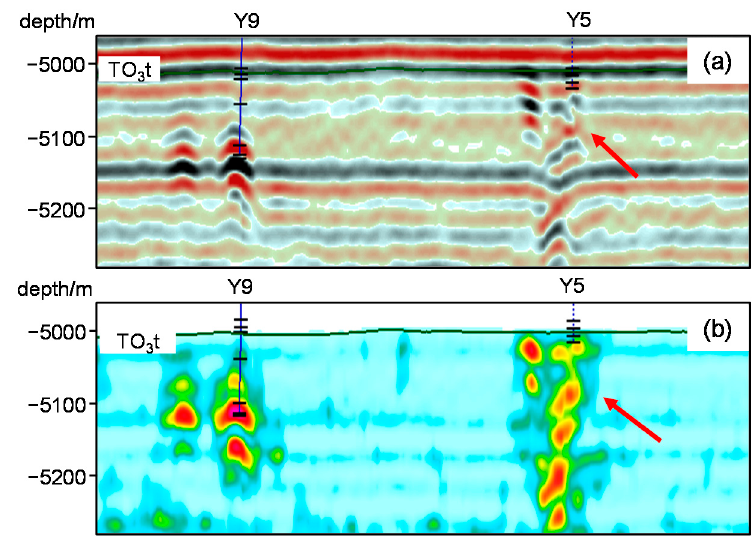
Figure 9. ( a ) Original seismic section and ( b ) the effect of two-facies (seismic facies and sedimentary facies) constrained reservoir inversion for a strike-slip fault zone (the yellow-red block showing fracture-cave reservoirs; TO 3 t: base of the Upper Ordovician).